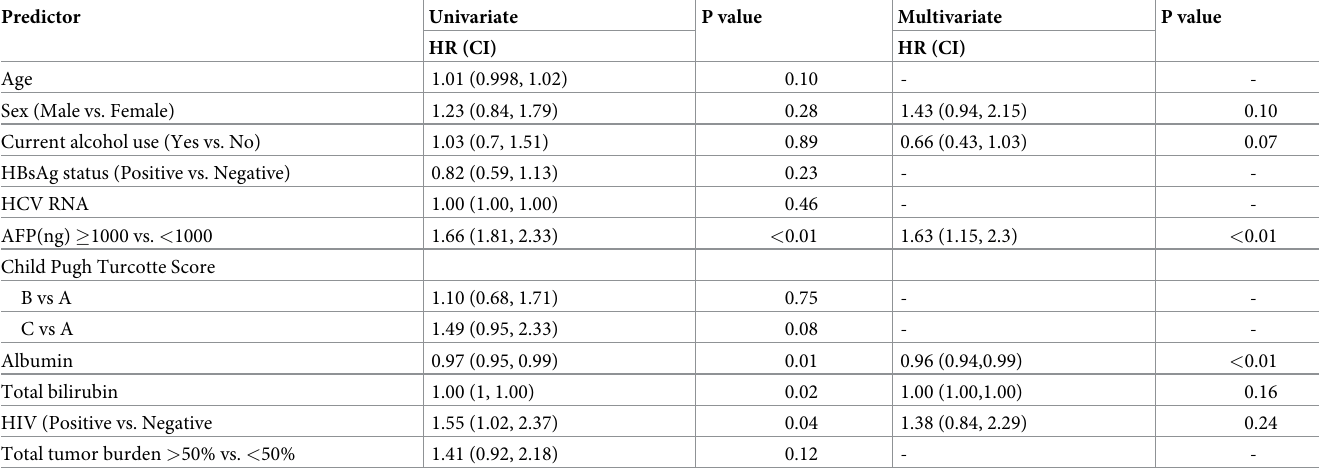
Table 2. Predictors associated with overall